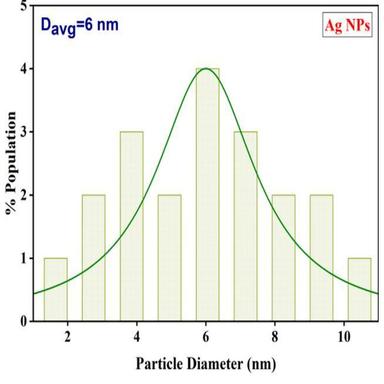
Particle size distributions of Ag NPs.